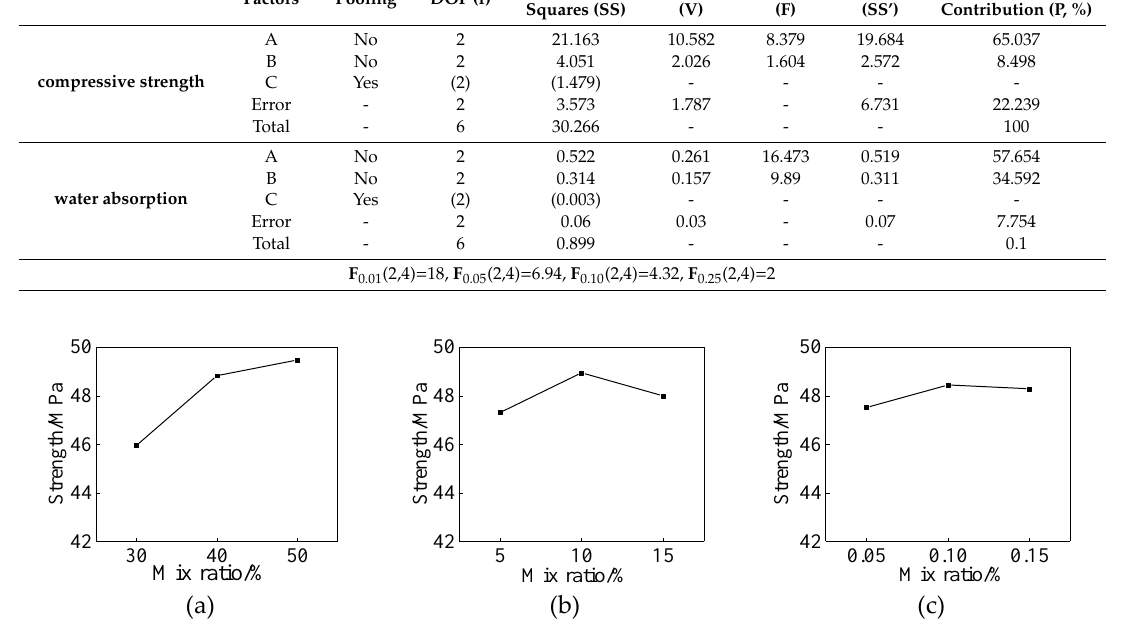
Figure 1. Impact of each factor on compressive strength, ( a ) Lithium silicate; ( b ) Sodium silicate; ( c ) Surfactant.